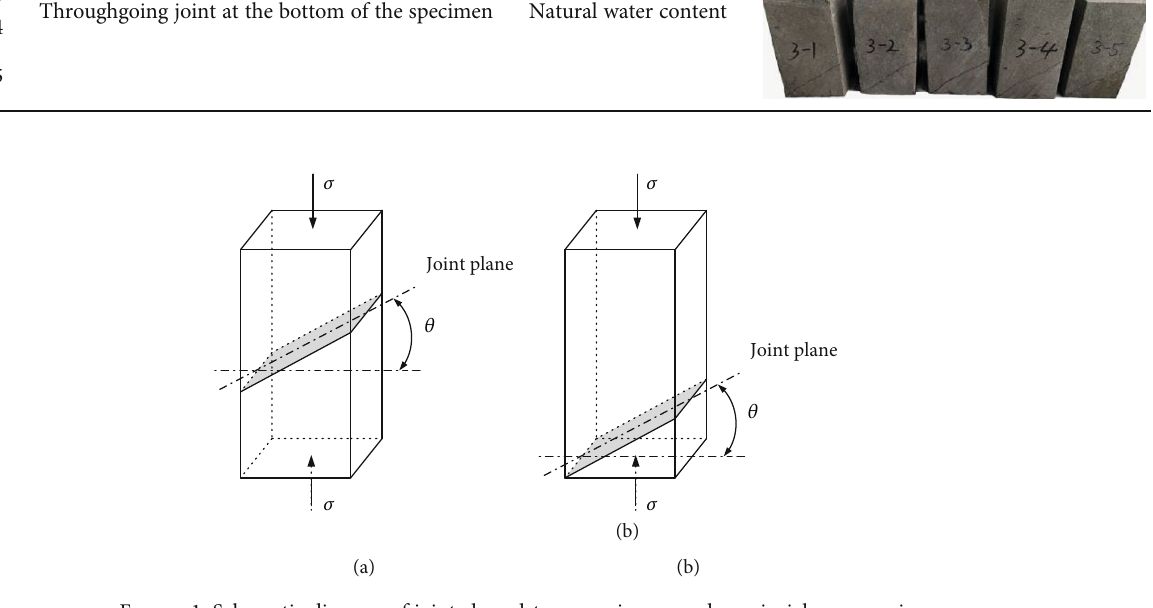
Figure 1: Schematic diagram of jointed sandstone specimens under uniaxial